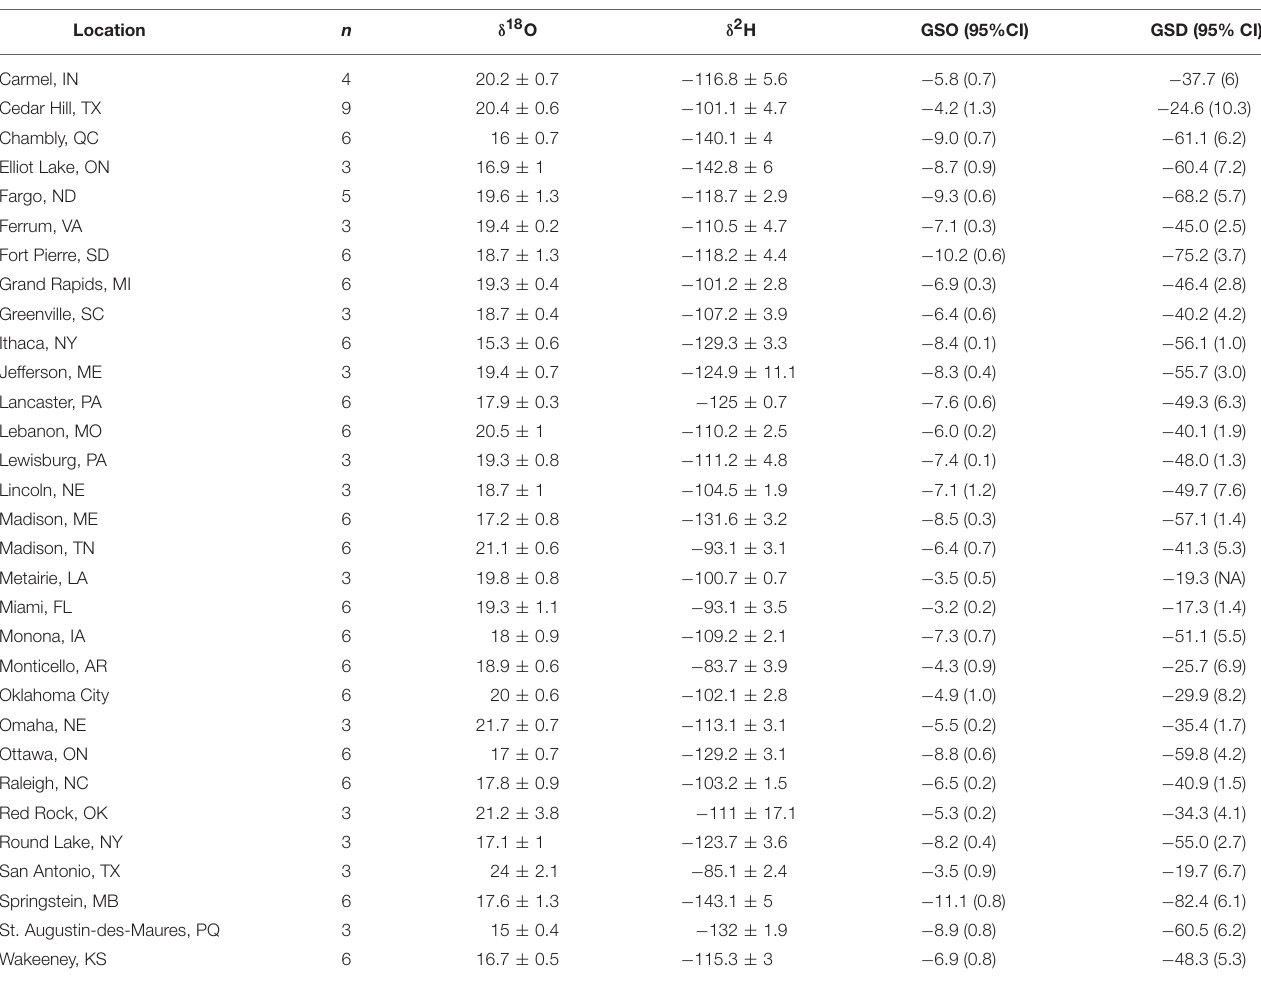
TABLE 1 | Mean isotope values ( ± 1 SD ‰ ) of wild reared monarch butterflies from eastern North America and mean growing-season δ 18 O p (GSO) and δ 2 H p (GSD) at each location plus the 95% CI shown in parentheses from Bowen et al. (2005).